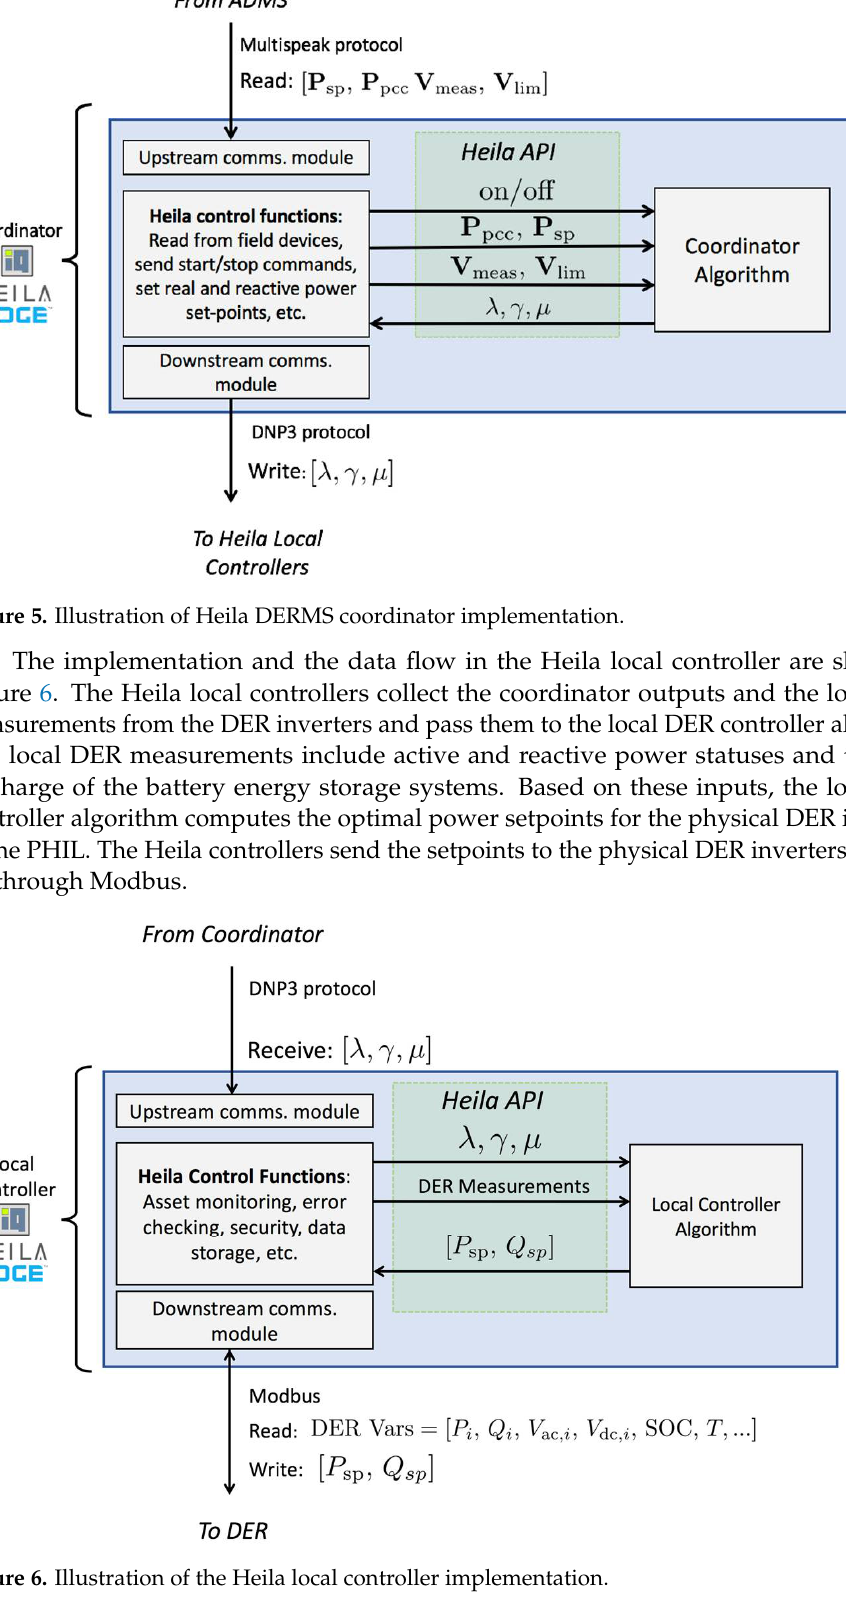
Figure 6. Illustration of the Heila local controller implementation.